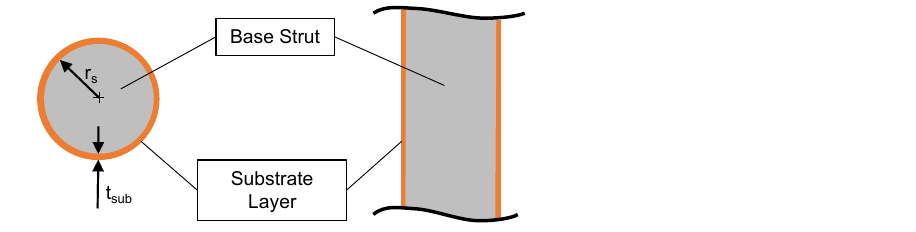
Figure 4. Cross section of the idealized corroded strut; in grey: base strut, in orange: compound of degradation/reaction products.